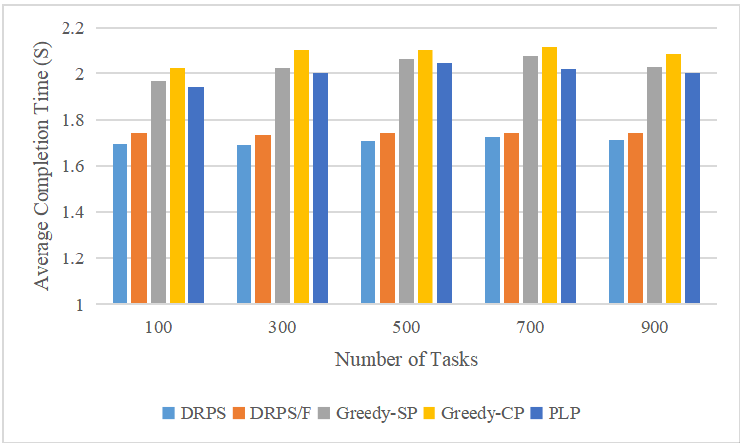
Figure 5. Results of the ACT.